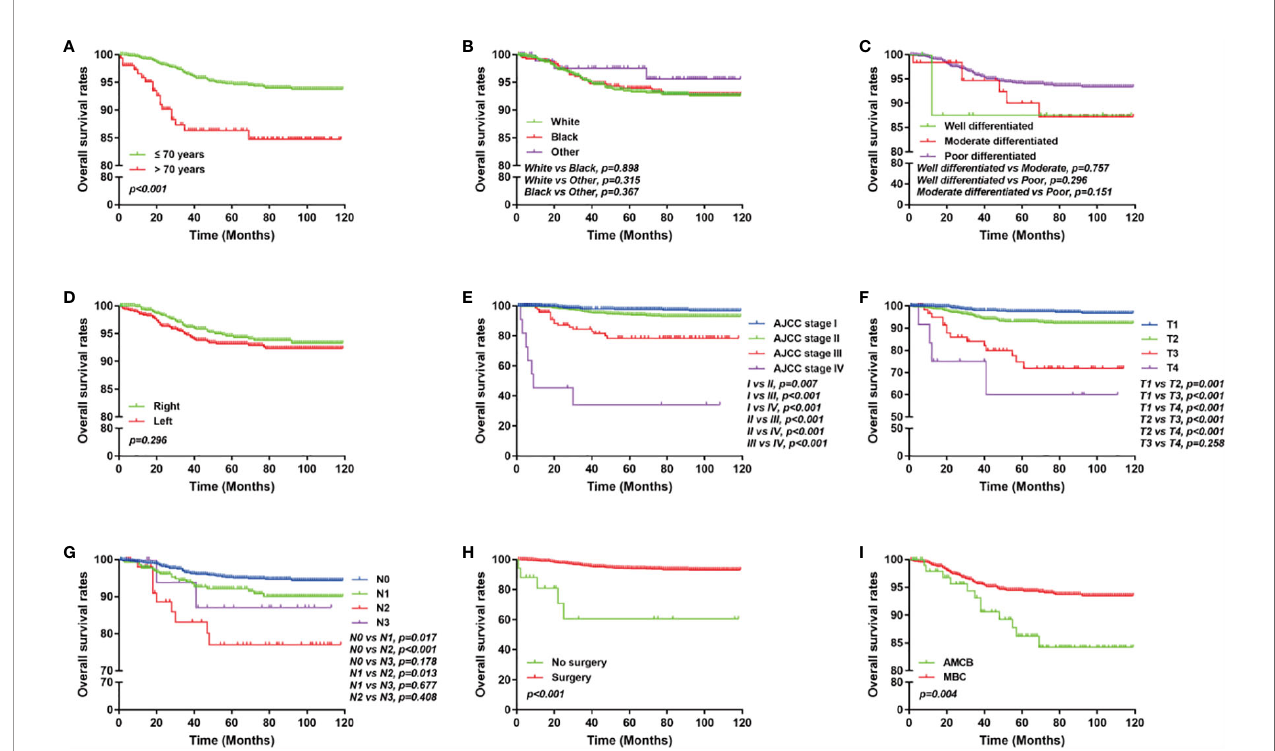
FIGURE 3 | Overall survival of MCB and AMCB patients using the Kaplan – Meier estimator with HR negativity strati fi ed by (A) age at diagnosis; (B) race; (C) grade; (D) laterality; (E) AJCC stage; (F) primary tumour size; (G) lymph node status; (H) surgery for primary tumour; (I) and histological